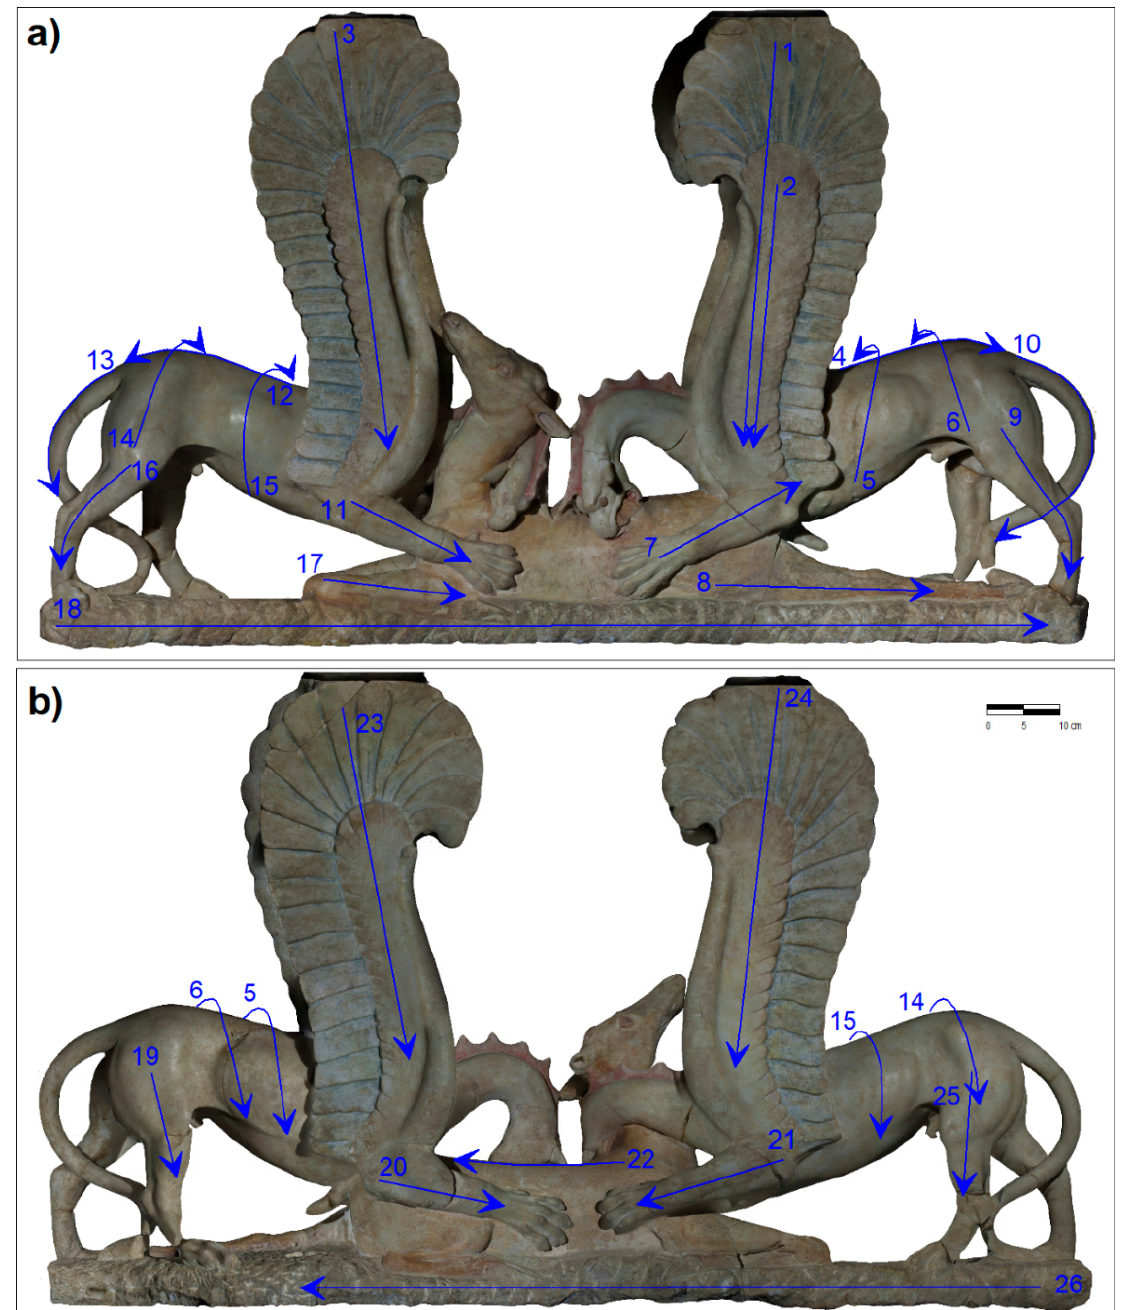
Figure 5. Location of ground-penetrating radar (GPR) data profiles in the frontal ( a ) and back ( b ) parts of the trapezophoros.